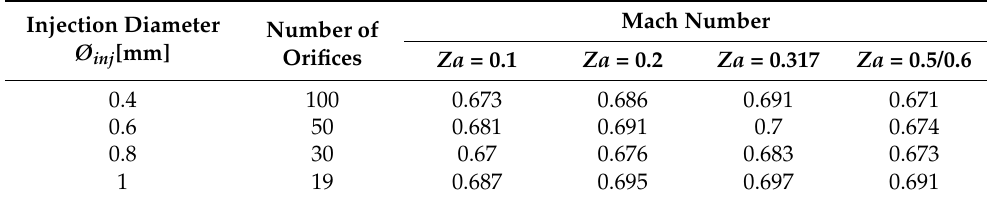
Table 4. Mach number in the injection section.